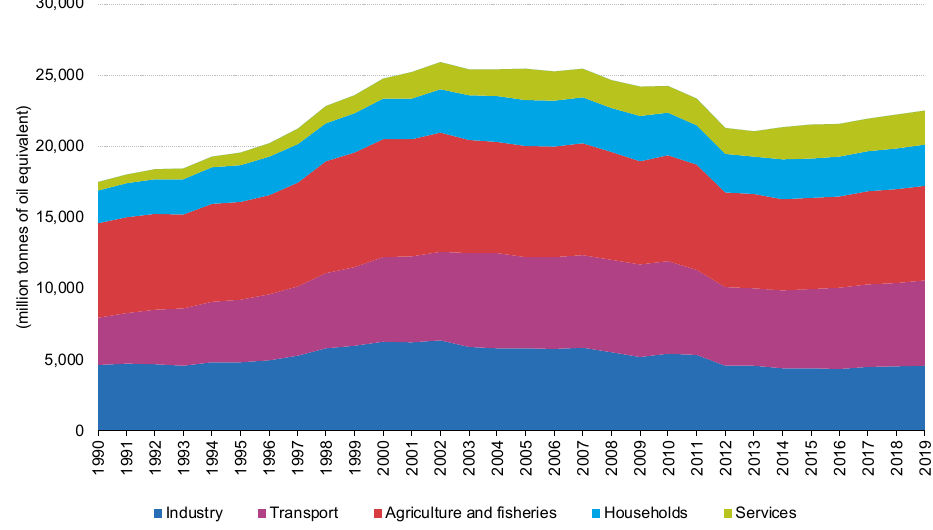
Figure 6. Final energy consumption by sector in Portugal from 1990 to 2019, measured in million tons of oil equivalent. The authors created this figure using data from Eurostat [1].